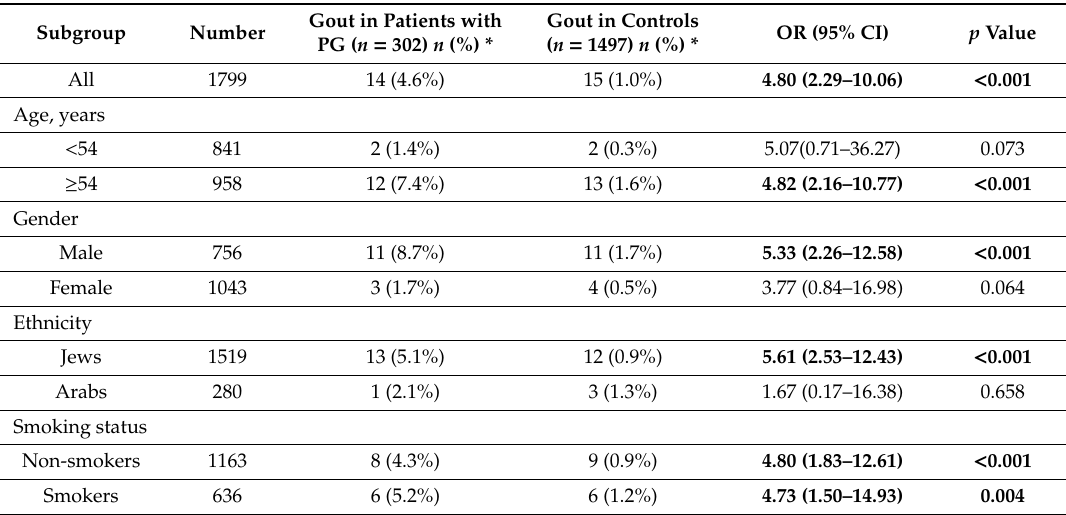
Table 4. The association between pyoderma gangrenosum and gout, stratified by age, sex, and ethnicity (a cross-sectional